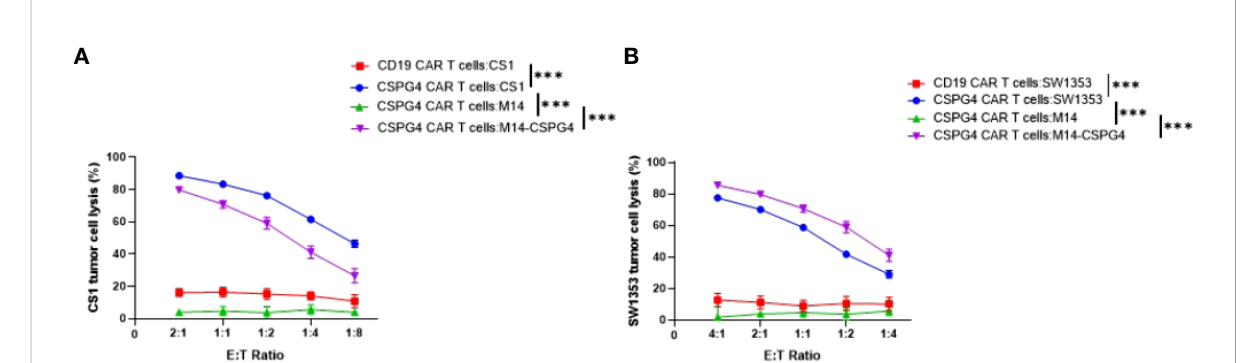
FIGURE 4 CSPG4-CART cells are effective in killing CSPG4-expressing chondrosarcoma cells. CSPG4 CAR T cells and target cells were co-cultured at indicated (E) T. ratios for 24 hrs. CAR T cells in the cell suspension were removed, and the viability of adherent target cells was quantitated by MTT assays. Mean ± SEM of cell lysis (%) of different cell populations in the chondrosarcoma cell line CS1 (A) and SW1353 (B) are shown. The human melanoma cell line Ml4 which does not express CSPG4 and M14/CSPG4 which express CSPG4 after stably transfected with CSPG4 plasmid DNA were used as speci fi city controls 25 . CD19 CAR T cells were also used as a negative control since none of the target cells express CD19. The experiments were performed in triplicate and repeated 3 times. Differences between CSPG4 CART cell-mediated cytotoxicity on different cell populations (including all E .T ratios) was detected using a chi square test in a two-way ANOVA. *** p <